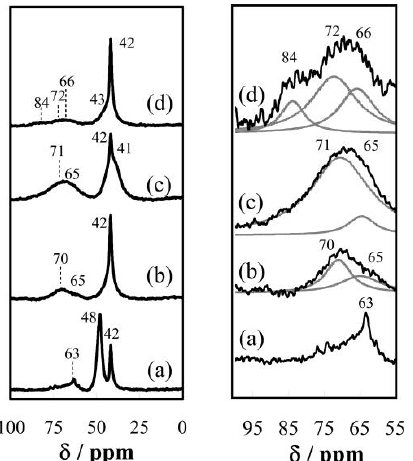
Figure 10. 31 P magic angle spinning (MAS) NMR spectra for trimethylphosphine oxide (TMPO) adsorbed ( a ) HTiNbO 5 nanosheets aggregate, ( b ) HNb 3 O 8 nanosheets aggregate, ( c ) HNbWO 6 nanosheets aggregate and ( d ) HTaWO 6 nanosheets aggregate, measured at room temperature. The